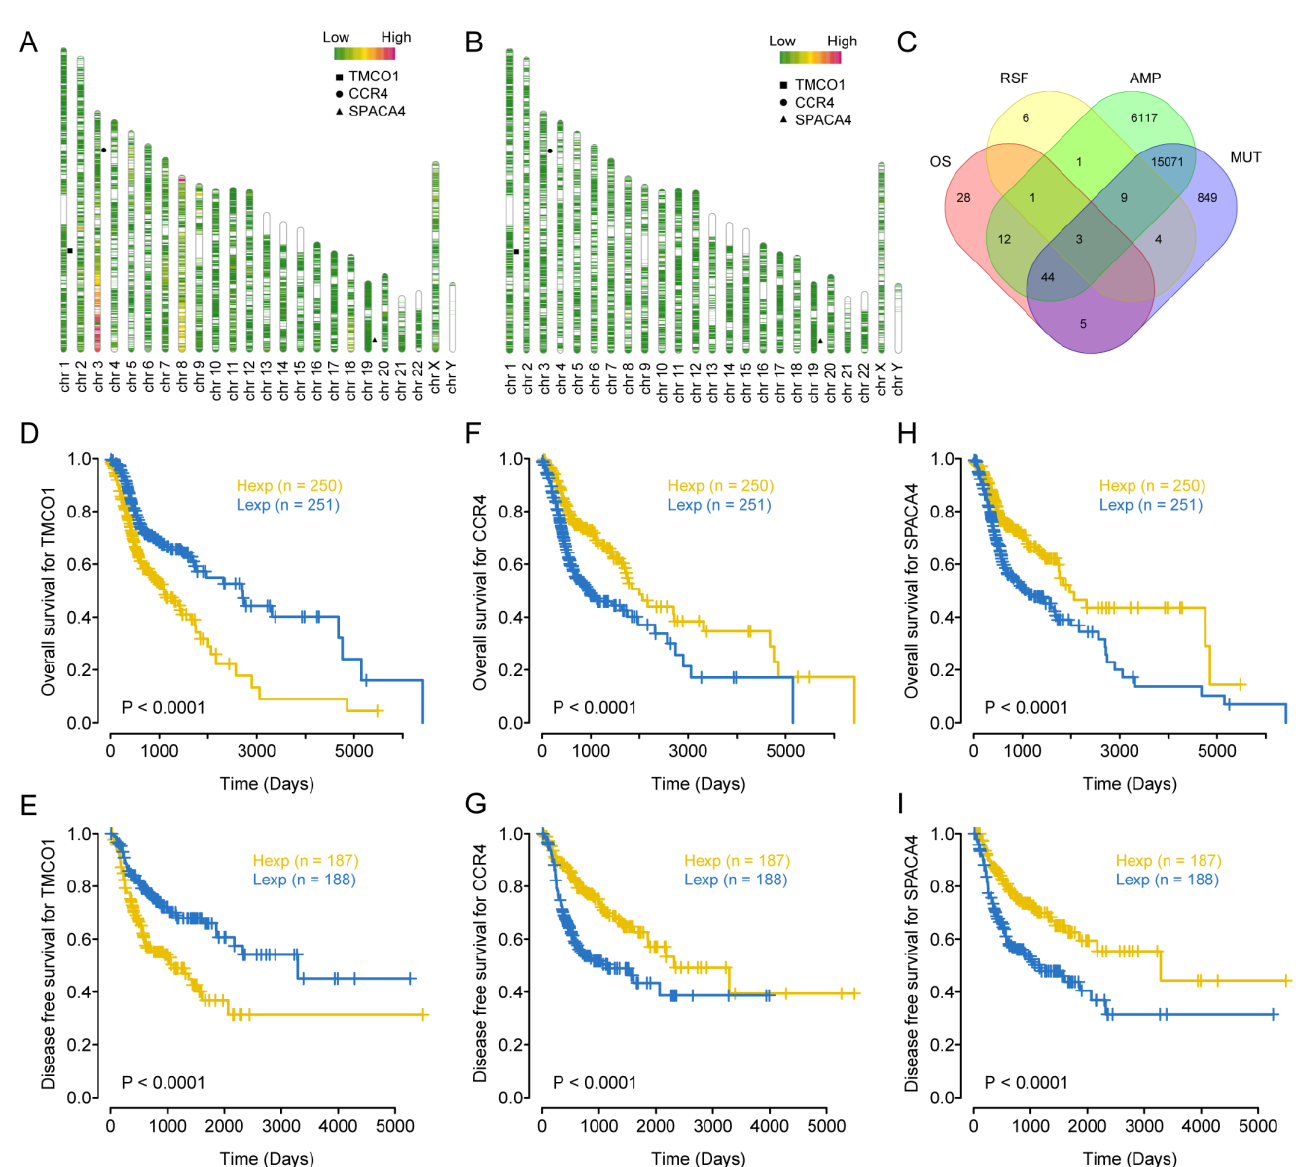
Figure 1. Identification of potential tumor antigens in HNSCC. ( A ) The map of amplification in HNSCC. ( B ) Map of mutation (MUT) in HNSCC. ( C ) Narrow-down analysis of potential tumor antigens with both amplified and mutated features, and significant OS and RFS prognosis (in a total of three candidates) in HNSCC. AMP represented amplification. Kaplan-Meier OS ( D ) and RFS ( E ) curves comparing the groups with a different TMCO1 expression in HNSCC. Kaplan-Meier OS ( F ) and RFS ( G ) curves comparing the groups with a different CCR4 expression in HNSCC. Kaplan-Meier OS ( H ) and RFS ( I ) curves comparing the groups with a different SPACA4 expression in HNSCC. Hexp and Lexp represented high expression and low expression, respectively.